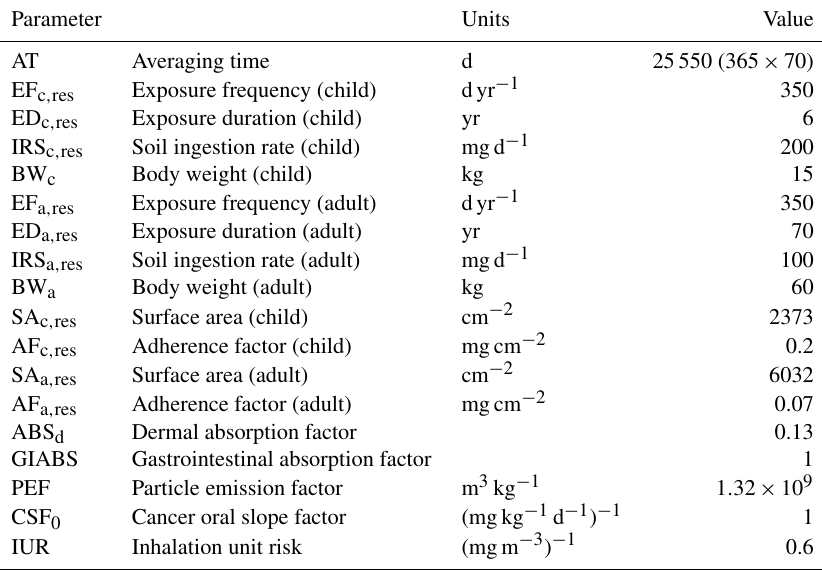
Table 2. Detailed parameters used in the incremental lifetime cancer risk assessment based on USEPA